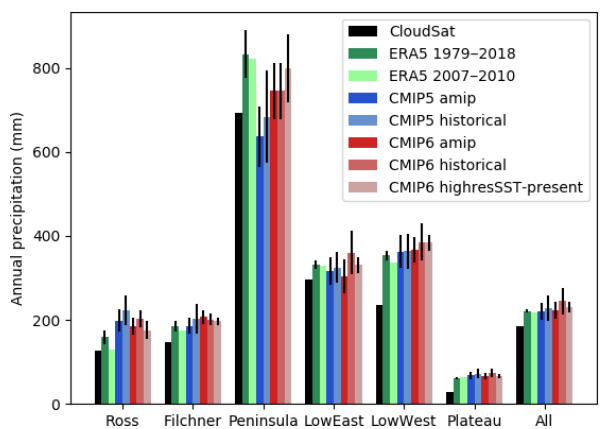
Figure 2. Average snowfall rate per region and for the entire conti- nent north of 82 ◦ S for CloudSat (black, 2007–2010), ERA5 (com- puted on 20 draws of 4 random years between 1979 and 2018, with standard deviation, and the 2007–2010 average), and the various CMIP ensembles. For CMIP, the ensemble medians and the 25th and 75th percentiles are